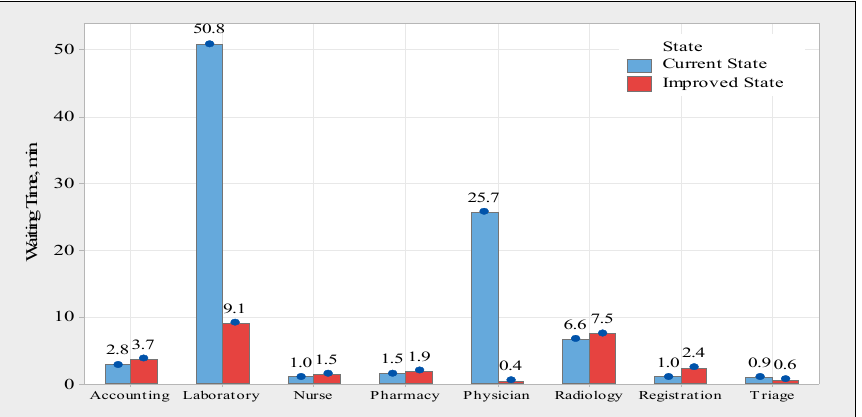
Figure 9. Comparison between the current state and improved state regarding the waiting time per process.